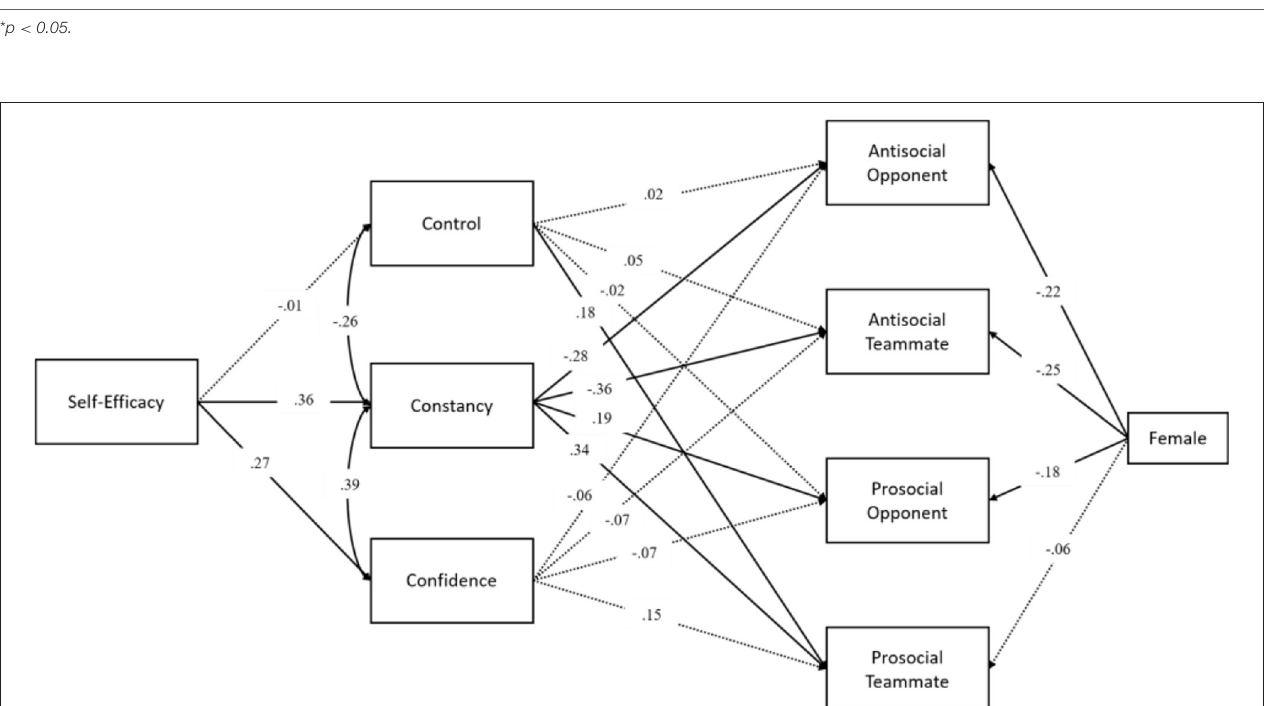
More importantly, the results for the indirect effects